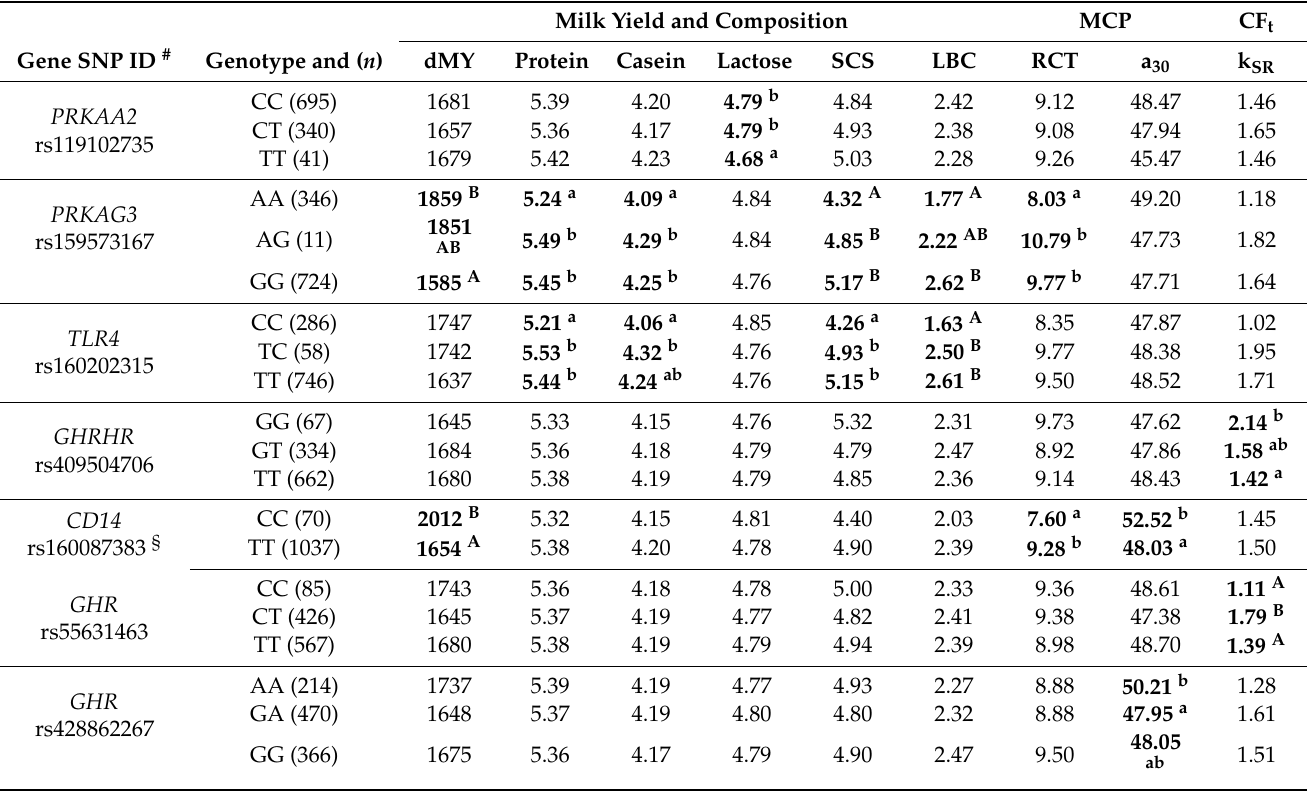
Table 3. Least square means of the milk yield and composition, the milk coagulation properties (MCP), and curd firmness over time traits (CF t ), according to the genotypes of the SNPs investigated in the Sarda sheep ( n = 1112). Milk Yield and Composition MCP CF